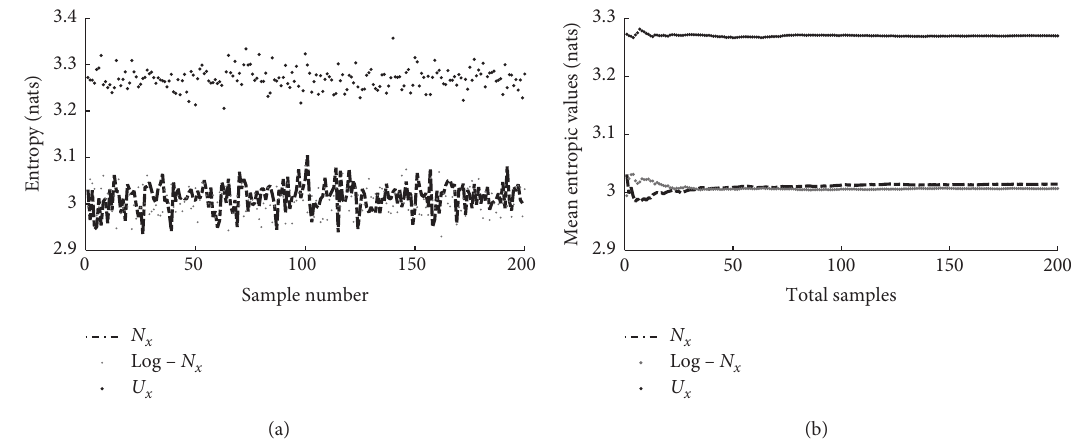
Figure 7: The entropy of PDF of wheel-rail vertical force due to variation of rail pad vertical stiffness. (a) Entropic value for specific samples; (b) the statistical mean value of entropy under different total samples.